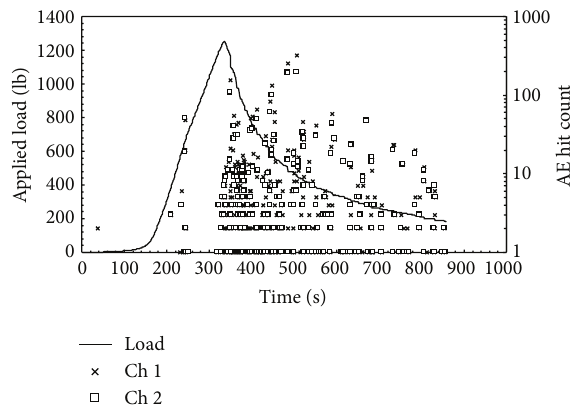
Figure 12: Strain wave detections of acoustic emission sensors from a panel under tensile loading. Initial crack extension occurred around 360 seconds and continued under displacement control.